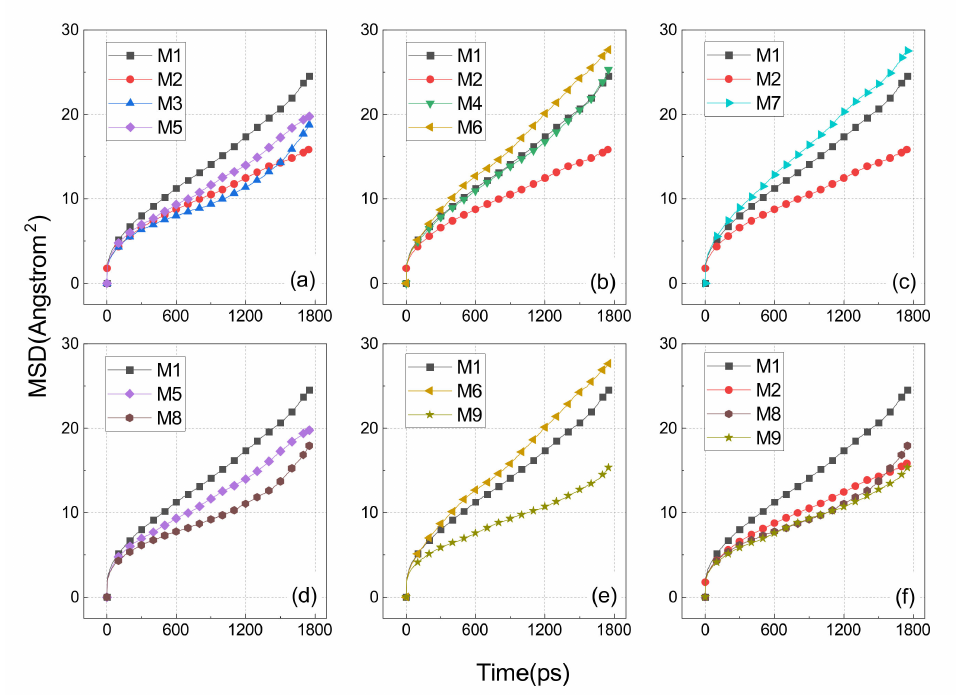
Figure 13. MSD of various cross-linked EPDM. ( a ) compares the cross-linking involving the C3 atom of the side chain; ( b ) compares the cross-linking involving the C9 atom of the side chain; ( c ) demonstrates the effect of oxidation on the cross-linking between the tertiary hydrogen carbons of the main chain; ( d ) shows the impact of oxidation on the cross-linking between the C3 atoms sitting on two side chains; ( e ) illustrates the effect of oxidation on the cross-linking between the C9 of the two side chains; and ( f ) is a comparison showing the two aged side chain–side chain